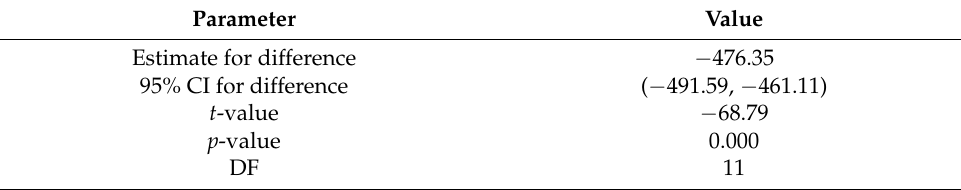
Table 13. Two-sample t -test